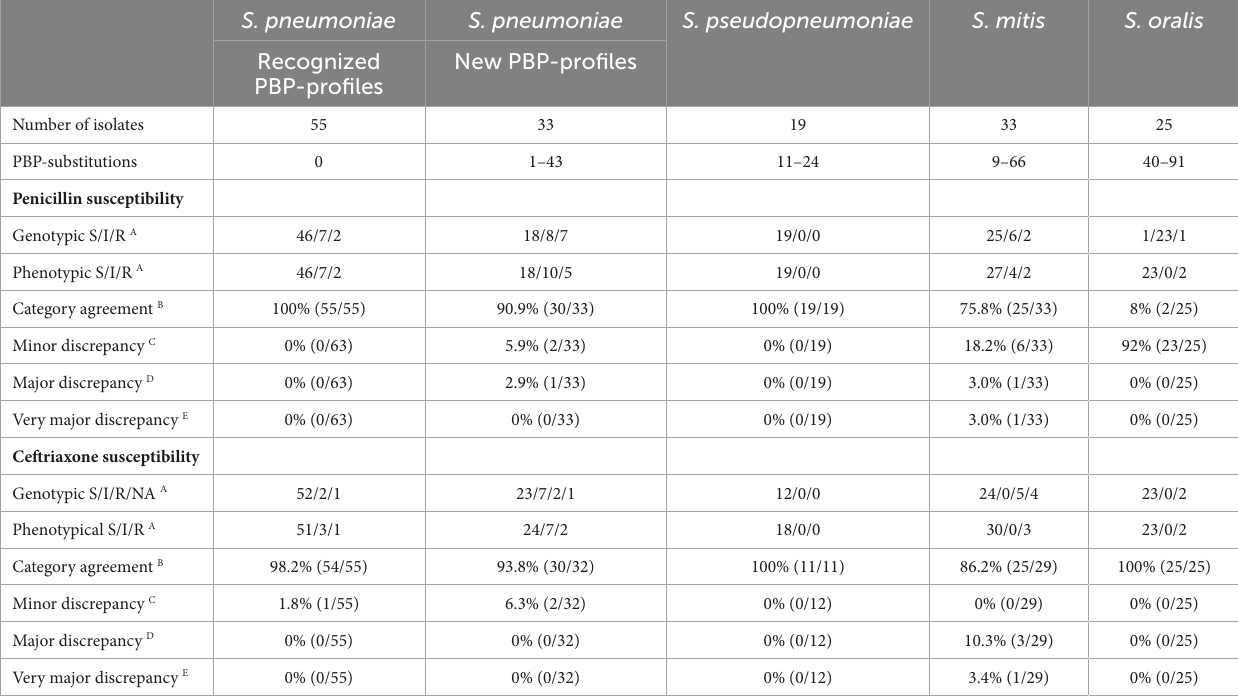
TABLE 2 Phenotypic-genotypic correlation for penicillin and ceftriaxone susceptibility in S. pneumoniae and non- S. pneumoniae mitis group streptococci.